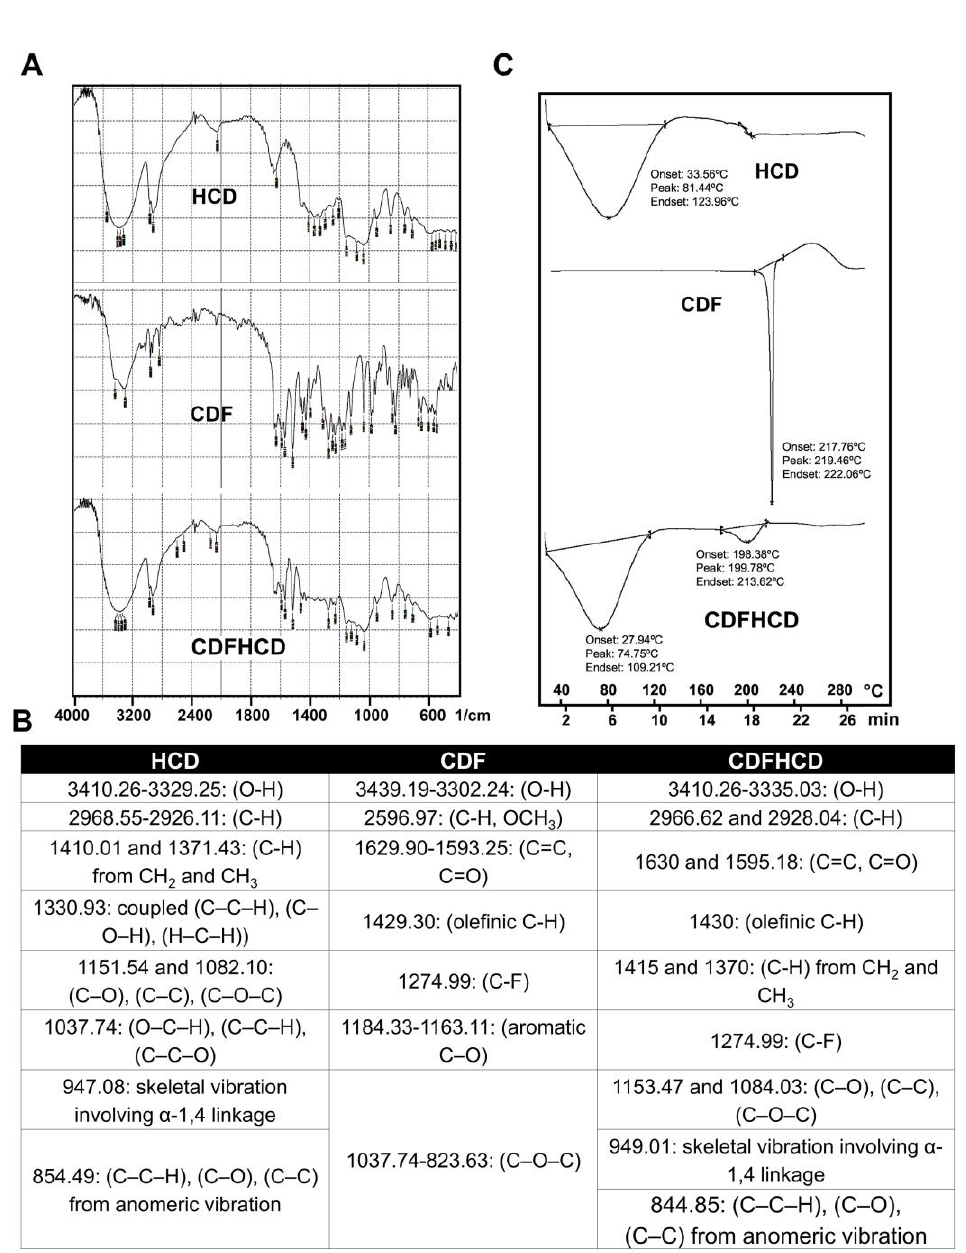
Figure 1. Spectroscopic and thermal Characterization of CDFHCD inclusion complex. ( A ). FTIR spectra of 2-hydroxypropyl- β -cyclodextrin (HCD), CDF, and CDFHCD inclusion complex. ( B ). The FTIR spectral assignments are summarized. ( C ). Differential scanning calorimetry (DSC) spectra of HCD, CDF, and CDFHCD inclusion complex.